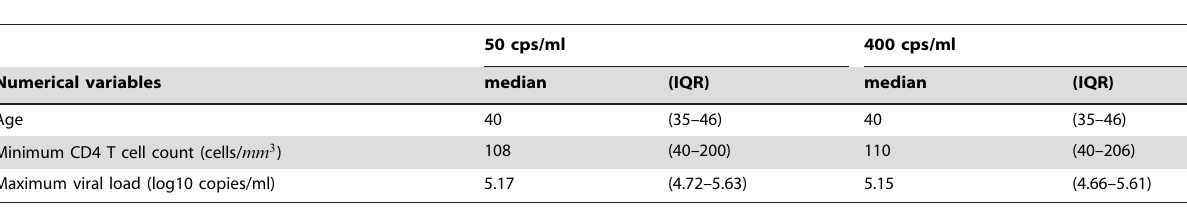
Table 1. Characteristics of the numerical predictors in the SHCS database.